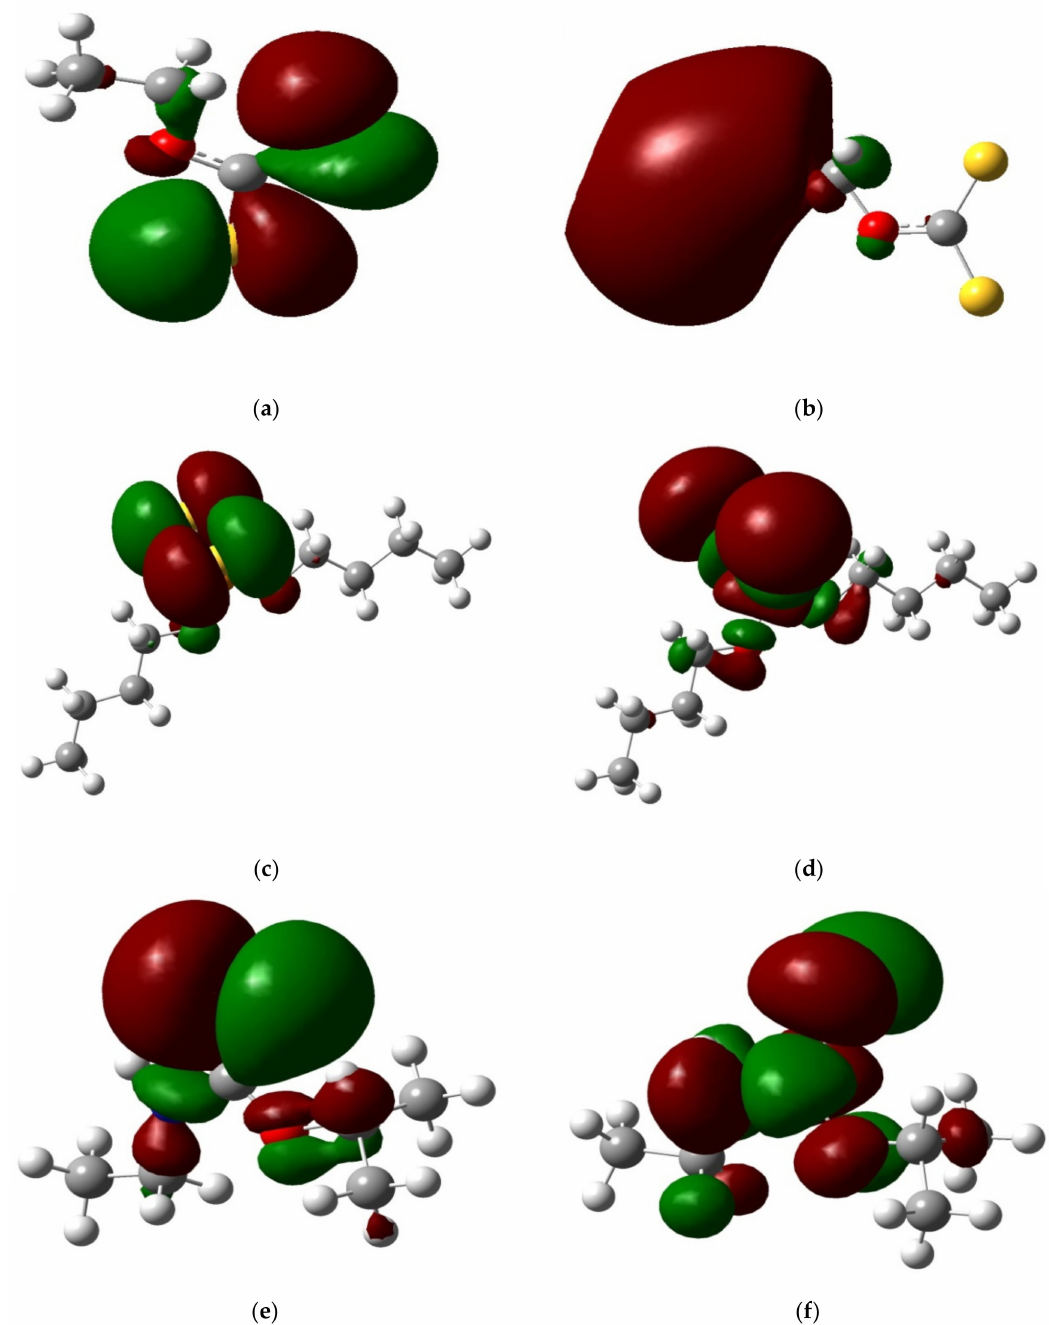
Figure 8. Electron cloud pictures of frontier molecular orbitals of optimized collector models (( a ) HOMO of SEX; ( b ) LUMO of SEX; ( c ) HOMO of ADDTP; ( d ) LUMO of ADDTP; ( e ) HOMO of IPETC; ( f ) LUMO of